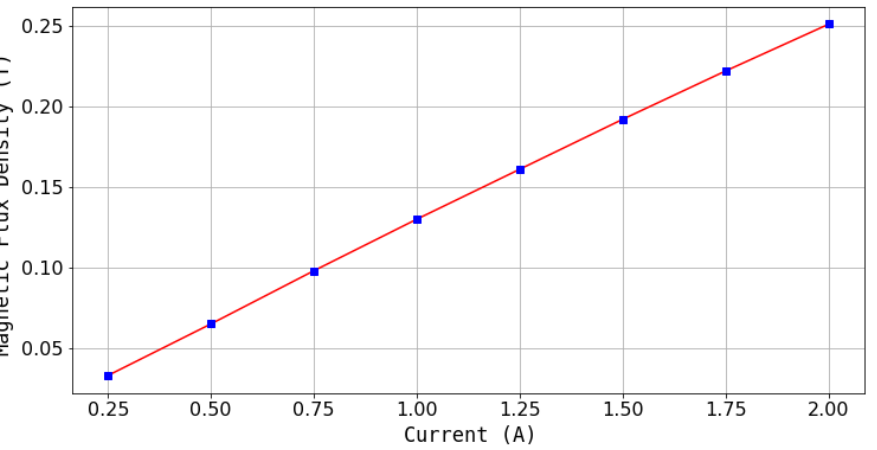
Figure 7. A graph of the correlation between current and magnetic flux density in the FEMM software simulation.